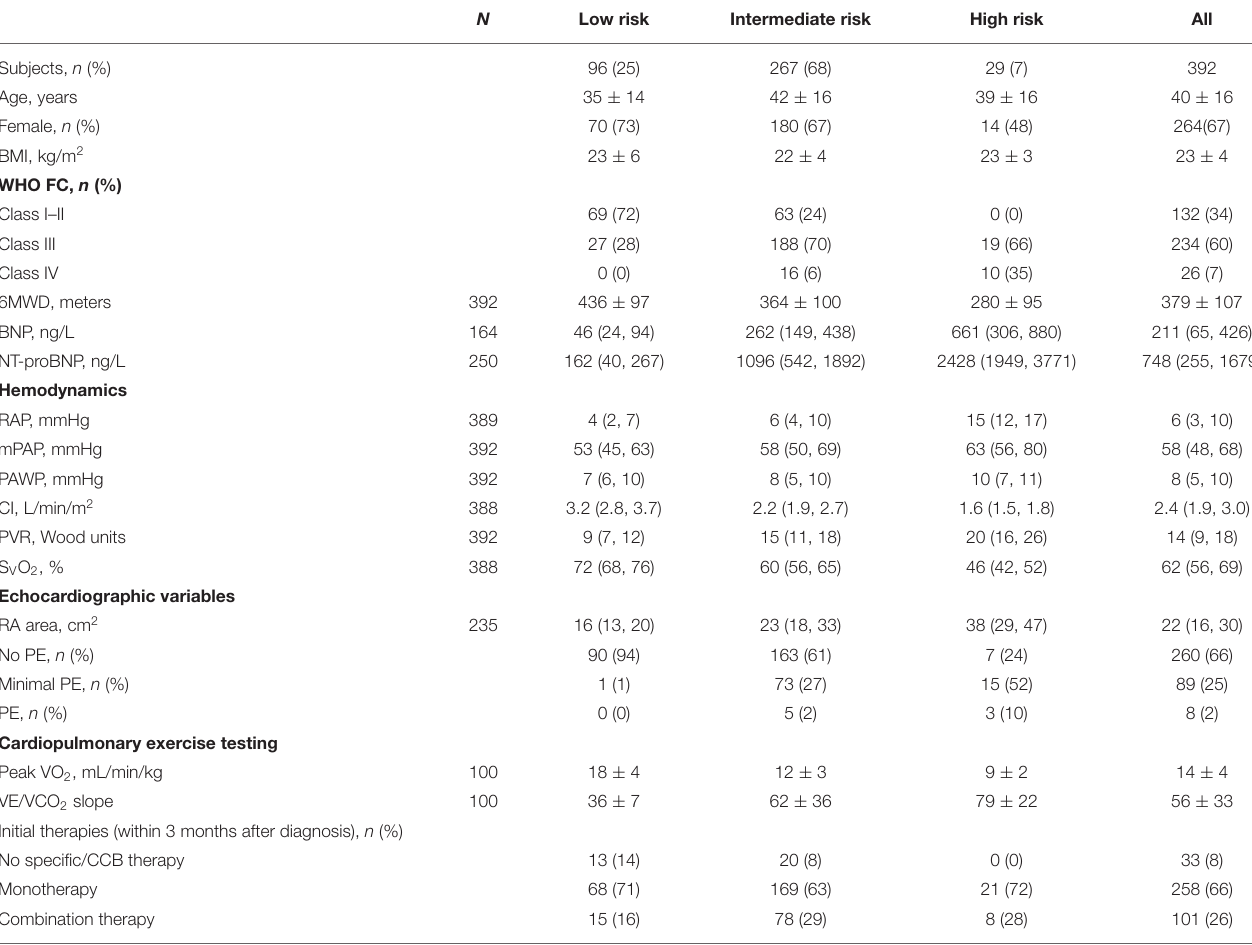
TABLE 2 | Characteristics of patients with IPAH in baseline risk stratification. N Low risk Intermediate risk High risk